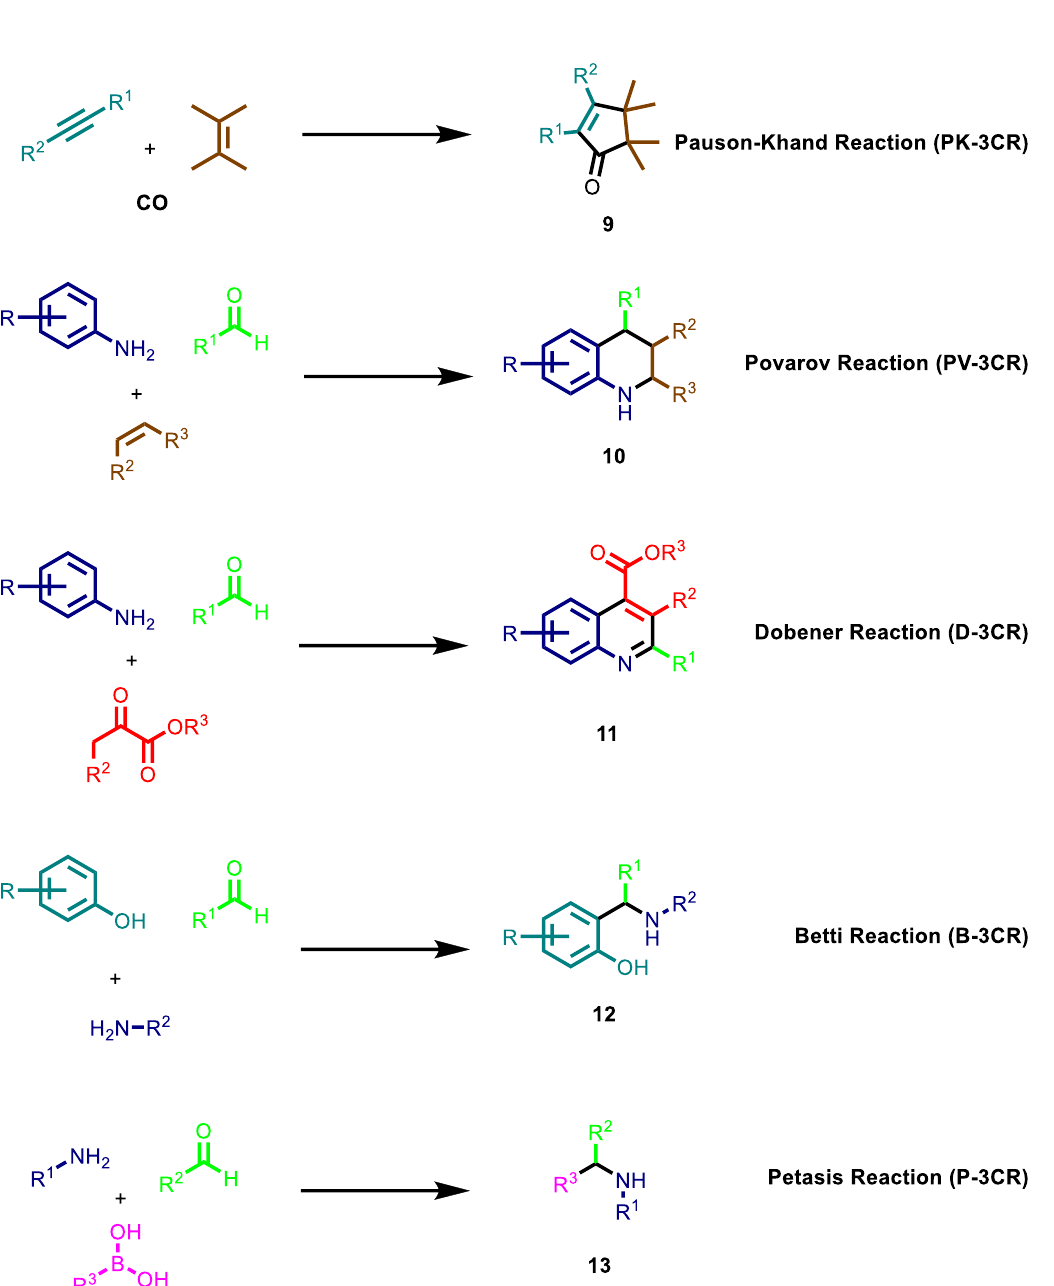
Figure 4. Other non-isocyanide-based multicomponent reactions.